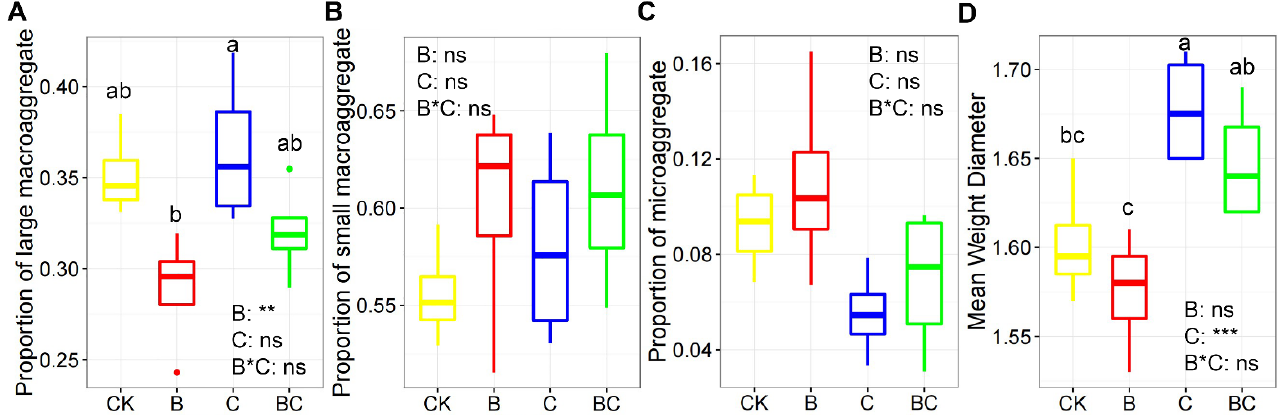
Figure 1. Box plot showing the proportion of large macroaggregate ( A ), small macroaggregate ( B ), microaggregate ( C ) and mean weight diameter ( D ) among treatments. Abbreviations: CK, control; B, biochar addition; C, compost addition; BC, biochar and compost addition. **, 0.001< p < 0.01; ***, p < 0.001; ns, not significant. The dot in the figure represents outlier. Bars without shared letters indicate significant difference at p < 0.05.